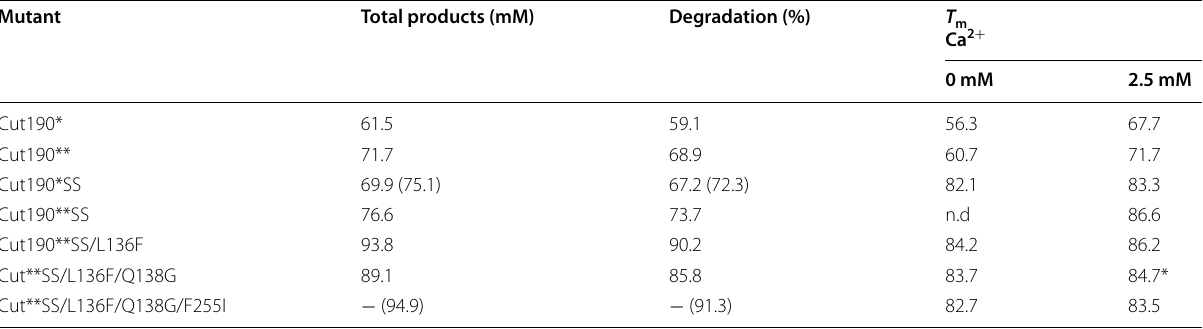
Table 4 Comparison of PET hydrolyzing activities